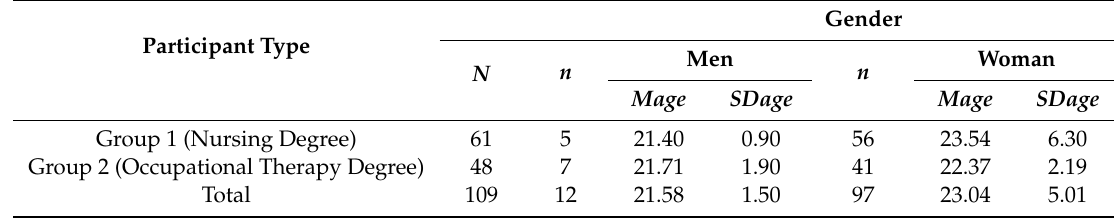
Table 1. Description of the sample and the variables: gender and age.